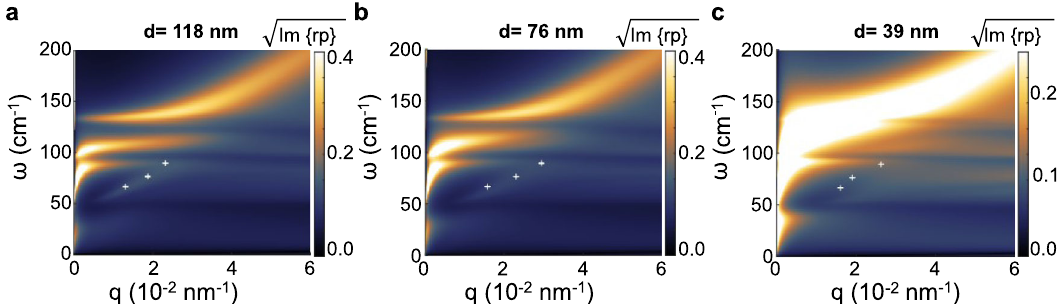
Fig. 6 Collective mode dispersions. a – c Collective mode dispersions of Bi 2 Te 3 slabs of different thickness d, rendered using the false color maps of Im{r p }. The parameters of the calculation are μ = 0.2 eV and a d = 118 nm; b d = 76 nm; c d = 39 nm. In the plots, the Fermi velocity is v F = 0.5 × 10 8 cm/s as for Bi 2 Te 3 from ref. 48 , the electron scattering rate is γ e = 1 THz as in ref. 4 , the vacuum and substrate permittivity are ε 0 = 1, and ε sub = 6.3. The white symbols correspond to the experimental data of Fig.